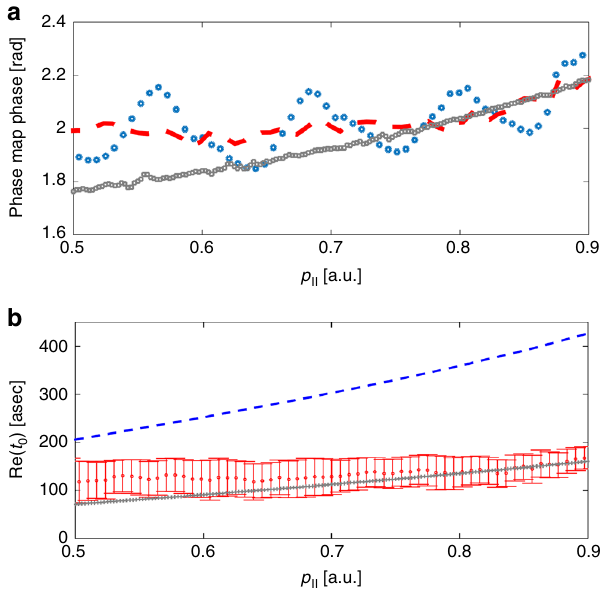
Fig. 3 Reconstruction of the ionization time for direct electrons. a Experimentally measured two-color phase, extracted along p ⊥ = 0 (blue circles) together with the CCSFA prediction (gray squares). The red dashed curve describes the experimental results after removing the oscillation associated with the ATI rings. b The reconstructed Re{ t 0 } (red) and the CCSFA ’ s Re{ t 0 } (gray) as a function of p || for p ⊥ = 0. The difference between the classical curve (blue dashed line) on the one hand, and the CCSFA curve and the experimental results on the other, re fl ects that the ionization times are con fi ned to a substantially narrower range in the quantum mechanical picture. An estimation of the error bars is explained signi fi cantly with Re{ t 0 } only, while being almost independent of Im{ t 0 } (see Supplementary Note 5). Figure 3b shows the reconstructed ionization times (red dots) along with the predictions of the CCSFA calculation (gray line), showing a very good agreement within the experimental uncertainty. The